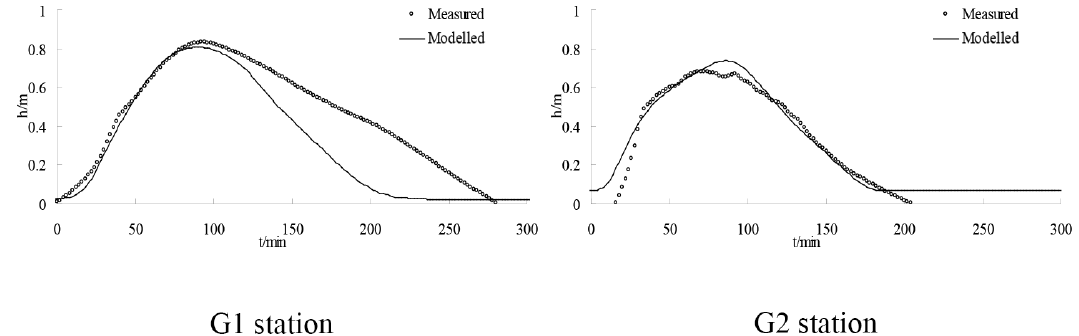
Figure 12. Comparison of the simulated and measured water depths at locations G1 and